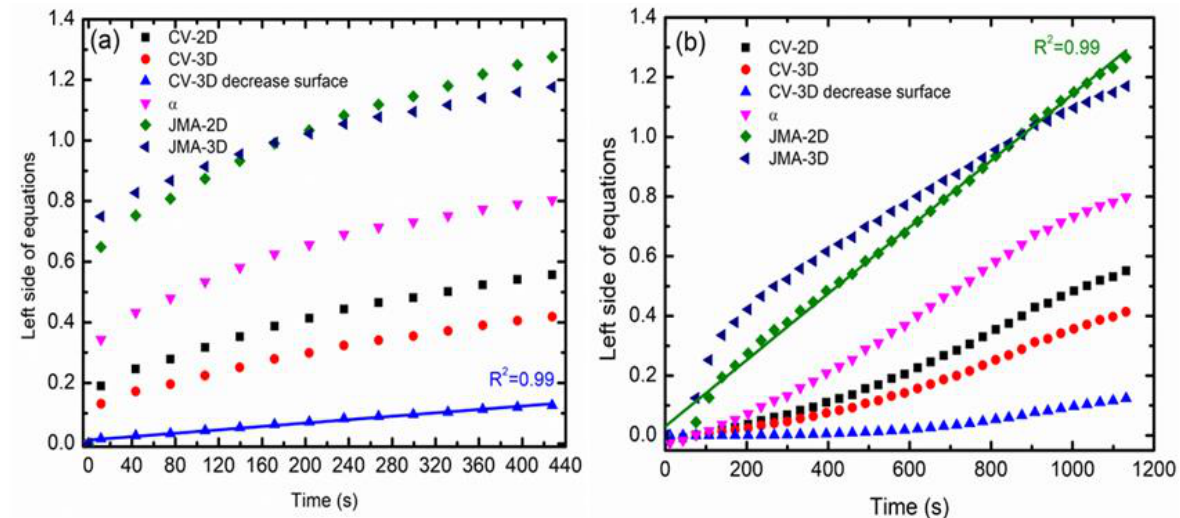
Figure 4. Plot of the resulting curves of different kinetics equations applied to experimental ( a ) ab- sorption kinetics at 200 °C and ( b ) desorption kinetics at 300 °C of MgH 2 + 10 wt.% CoTiO 3.